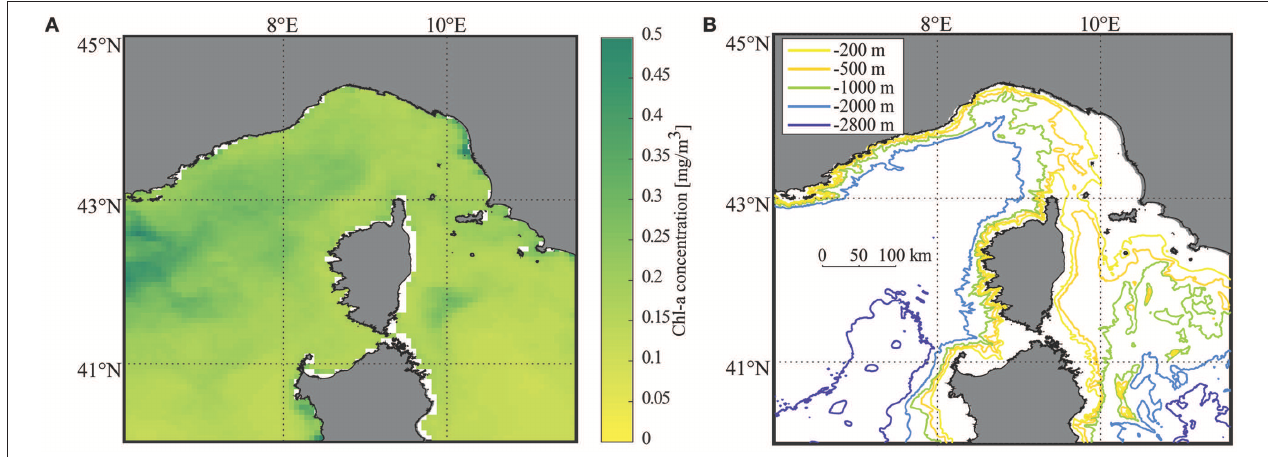
FIGURE 2 | Input data used to assess the exposure component of the risk maps using habitat suitability modeling. (A) An exemplification of a temporal snapshot (June 2006) of surface chlorophyll-a (chl-a) concentration satellite data, see text for data sources. (B) Bathymetry of the Pelagos Sanctuary area as provided by The British Oceanographic Data Centre